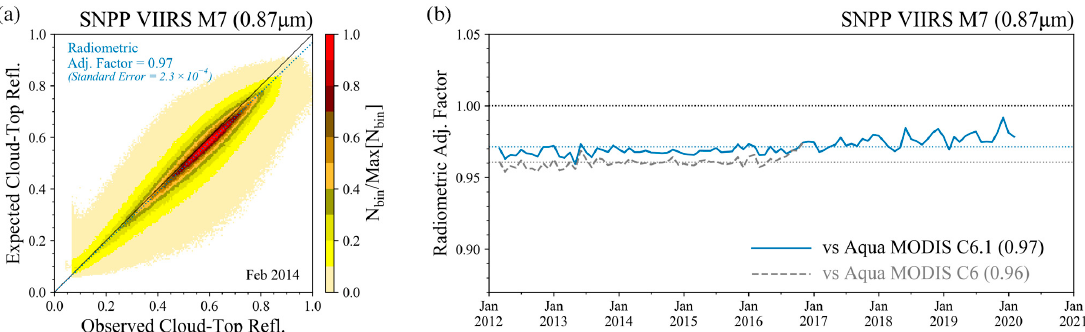
Figure 3. Example shortwave radiometric assessment results for the SNPP VIIRS 0.87 µ m channel (M7). ( a ) 2-D histogram of VIIRS expected and observed cloud-top reflectance, normalized by the maximum value in the histogram, for February 2014 (more than 6 million total co-locations with Aqua MODIS). The VIIRS radiometric adjustment factor derived for this month is indicated in the blue text and the slope of the dotted blue line; the standard error of the slope is also denoted. ( b ) Time series of monthly radiometric adjustment factors over the time period